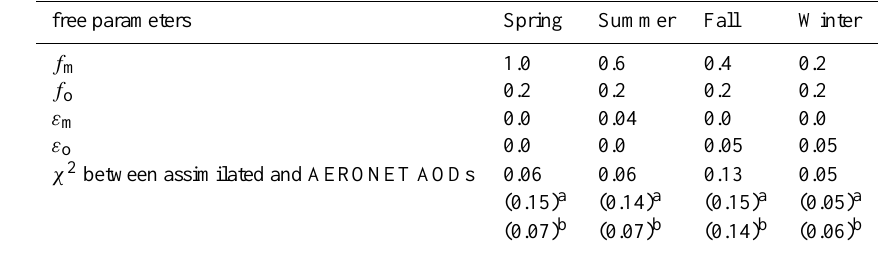
Table 6. The best free parameters obtained from the sensitivity tests for all four seasons, 2006. free